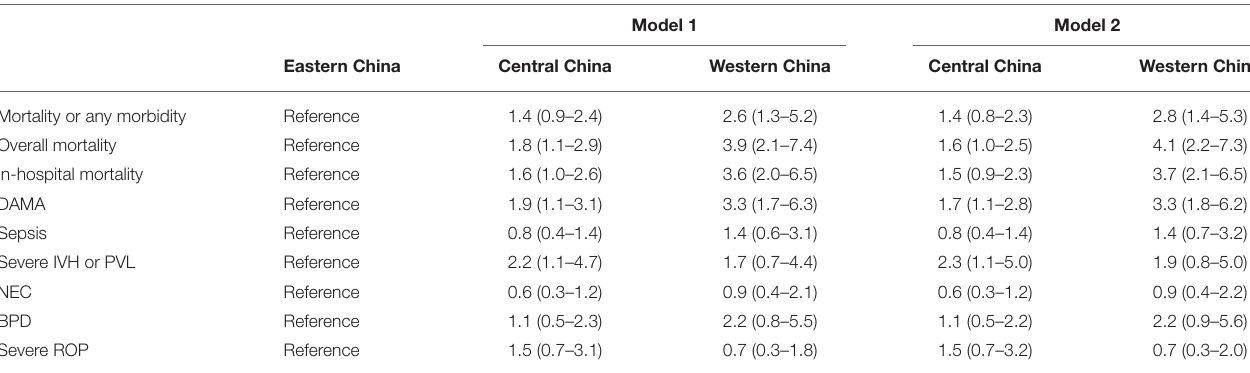
TABLE 3 | Comparison of adjusted outcomes for preterm infants admitted to NICUs in three regions of